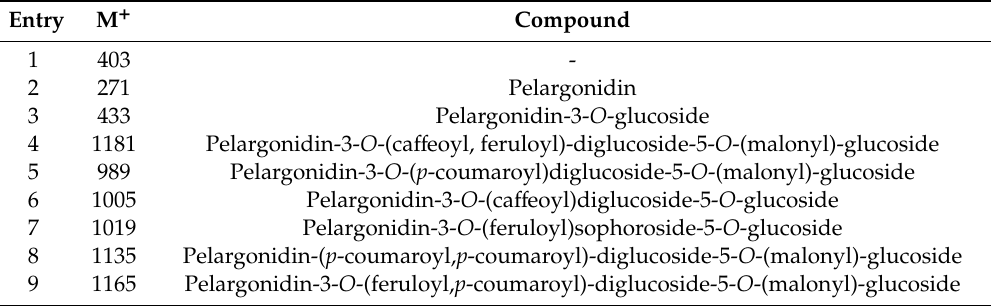
Table 2. Mass spectrometry data and putative identification for red radish extract based on the known molecular weight and observed M + .